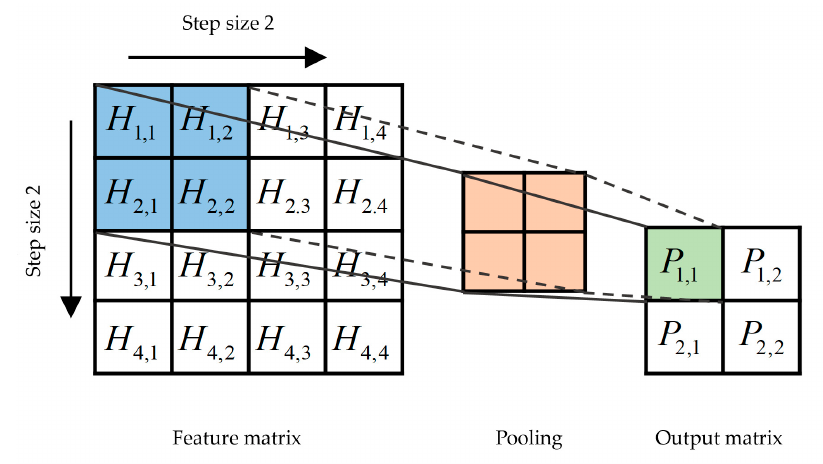
Figure 3. Example of max pooling.